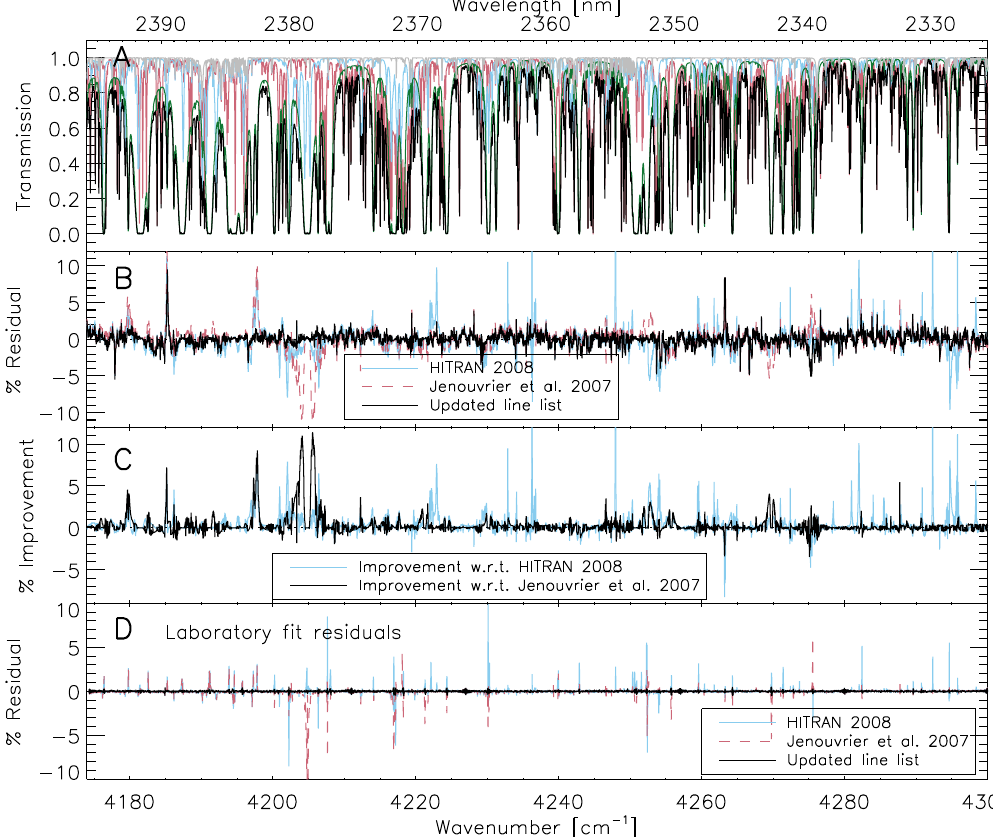
Fig. 4. Impact of the updated spectroscopy on the fit residuals of an FTS spectrum taken at Paramaribo. (A) Measured normalized trans- mission (black). The different colours show the contributions of all the modelled species (red: CH 4 , green: H 2 O, blue: HDO, grey: sun reference). (B) Residuals, plotted as 100 × (spectrum-model) for a fit using HITRAN 2008 (blue), the original Jenouvrier et al. (2007) spec- troscopy (red) and the updated spectroscopy from this work (black). Note that we have set the Jenouvrier et al. (2007) spectroscopy below 4200 cm − 1 equal to HITRAN 2008. (C) Difference between the absolute values of the residuals using HITRAN 2008 and this work (blue) and the original Jenouvrier et al. (2007) and this work (black). Positive values indicate improved residuals, while negative values indicate deteriorated residuals. The majority of the residuals improved w.r.t. HITRAN 2008 and Jenouvrier et al. (2007), while only a few residuals deteriorated. (D) The corresponding laboratory fit residuals of the water lines from Fig.